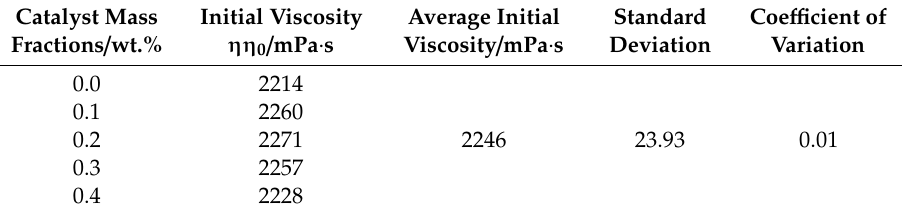
Table 3. Initial viscosity for HTPB/HDI-trimer system in different mass fraction of DABCO at 35 °C. Catalyst Mass Fractions/wt.%